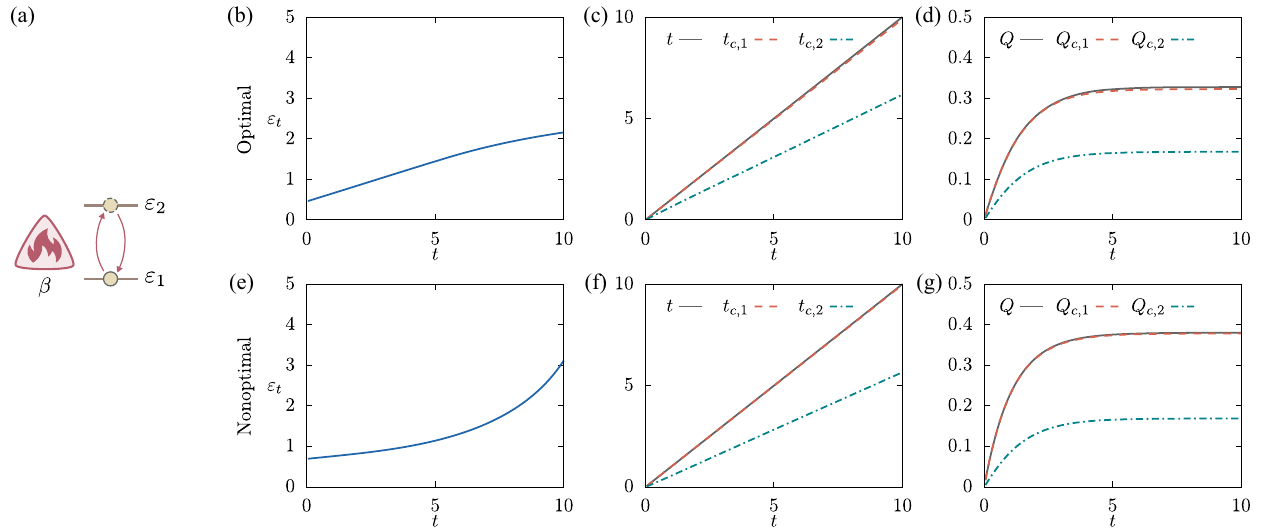
FIG. 5. Numerical illustration of the classical thermodynamic speed limits and finite-time Landauer principle for both optimal and nonoptimal protocols. (a) Schematic of the two-level system. (b),(e) Time variations of the control parameters of the optimal and nonoptimal protocols. (c),(f) Numerical verification of the speed limits t ≥ t ≥ Q Q ≥ Q . The other parameters are fixed as β ¼ 10 and τ ¼ 10 . The weighting factor λ is set such that ð 1 − λ Þ = λ ¼ 10 5 c; 1 c; 2